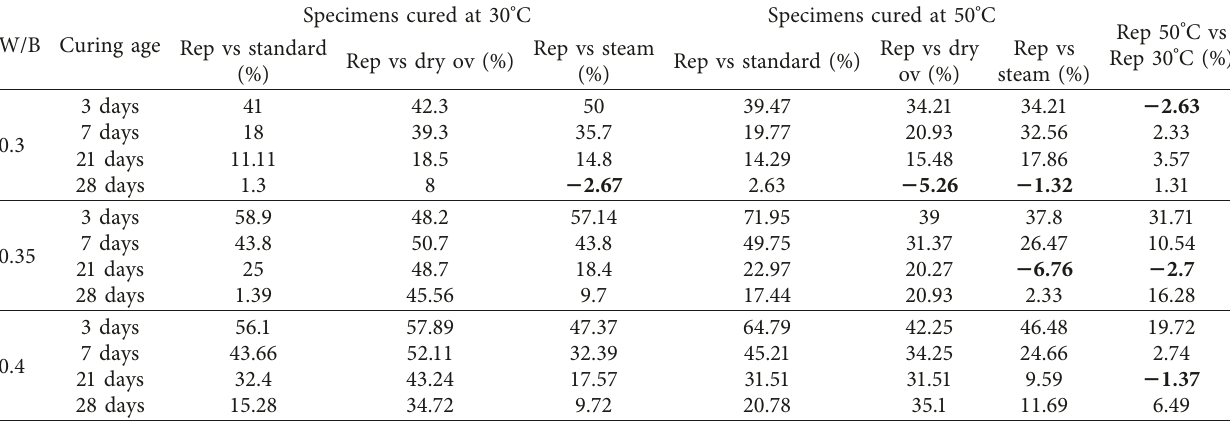
Table 4: Percentage increase in compressive strength with oven replacement compared with other curing conditions. Specimens cured at 30 ° W/B Curing age